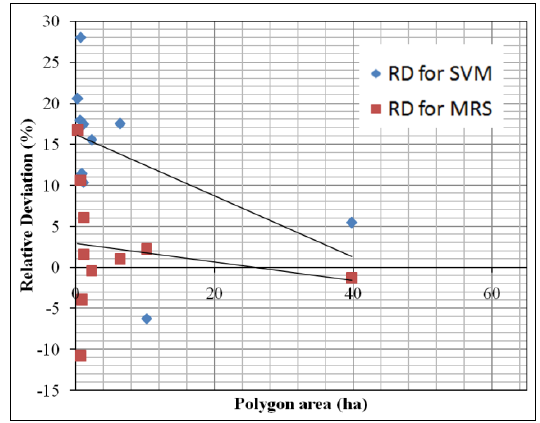
Figure 7: Relative Deviation in area from SVM and MRS Grid-wise analysis showed variations in GHI values 0.0 to 1 (Figure 8). The value 1 in GHI represents that the whole grid is covered by green space. The coverage of green space continuously decreasing in grid with decrease in GHI value till it approached towards nil. The less GHI from SVM and MRS is due to less mapped area of green cover by both these methods. However, the GHI is showing high value for the HMC. The main reason for this is the green university campus of Chaudhary Charan Singh (CCS), Haryana Agricultural University (HAU) which covers 2921.43 ha of HMC. This is approximately 70 % of the total geographical area of HMC. The campus has farm fields, big patches of trees and ornamental gardens. The proper management of green cover inside the University campus maintains the greenery of vegetation present. These were detected properly by SVM algorithm.